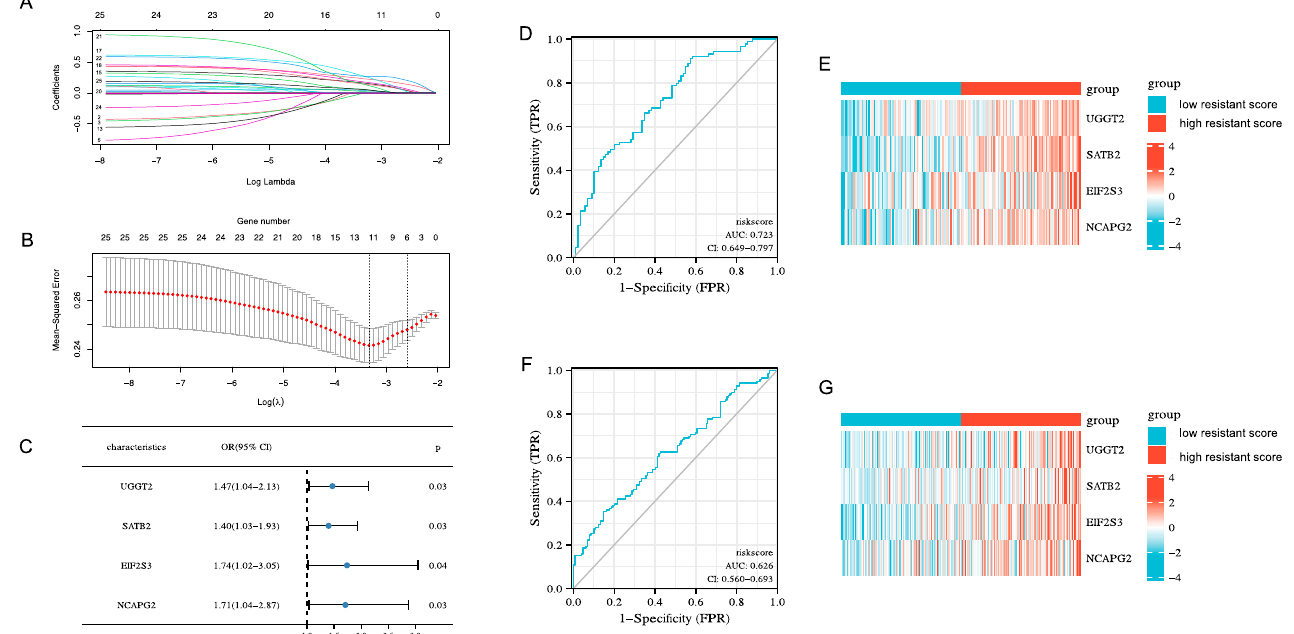
Figure 2. Constructing an erlotinib-resistant-related model by candidate genes. ( A , B ) Establishment of the erlotinib-resistant-related model. ( C ) Coefficient of logistics regression equation model of erlotinib-resistant-related genes; OR, odds ratio. ( D ) Prediction of patients’ sensitivity to erlotinib in this model using diagnostic ROC curves. ( E ) Heatmap showing gene expression in high- and low-resistance-score groups. ( F , G ) ROC curve and heatmap for validation group.